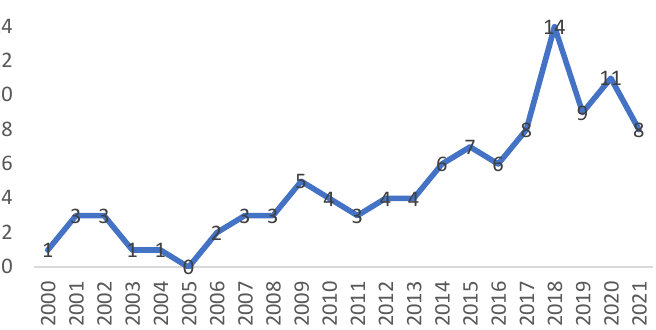
Figure 1. Distribution of research articles.